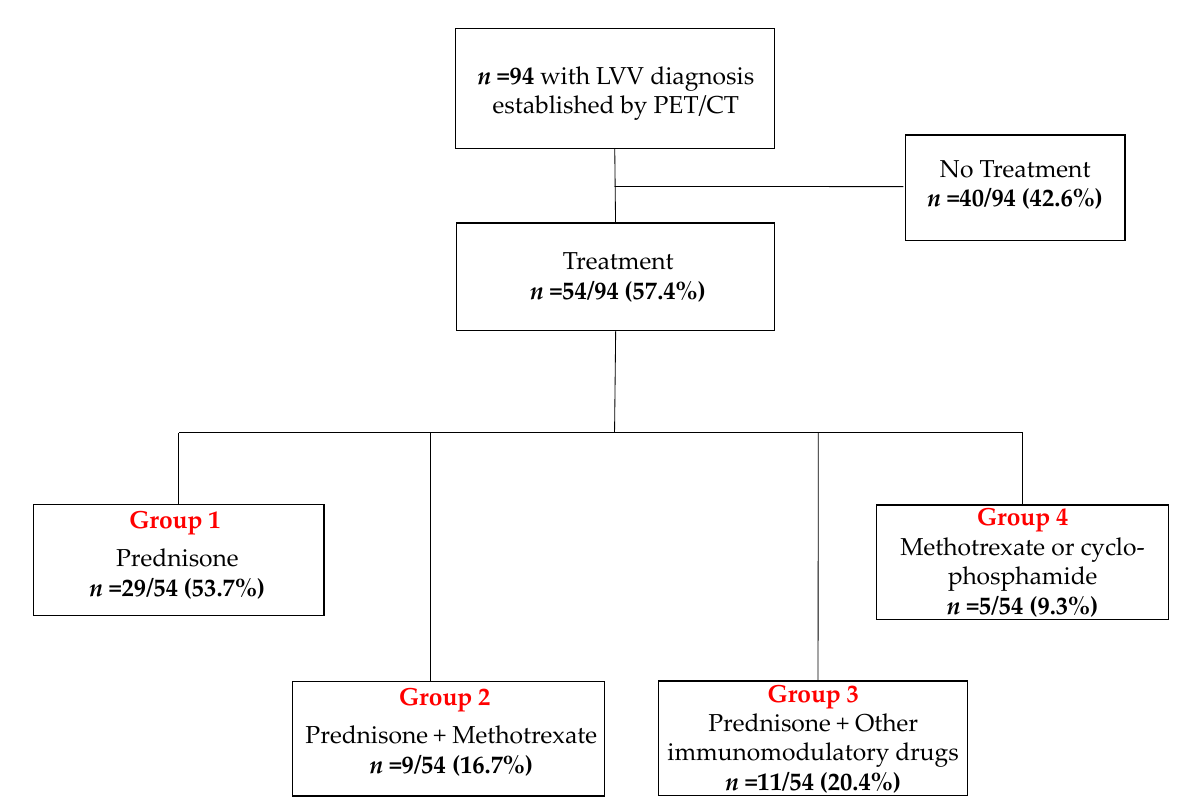
Figure 1. Overview of the enrolled subjects. Other immunomodulatory drugs in Group 3 included mycophenolate mofetil, azathioprine, rituximab, and leflunomide. Patients allocated to Group 4 were excluded from further analysis due to the low number of subjects. LVV = large vessel